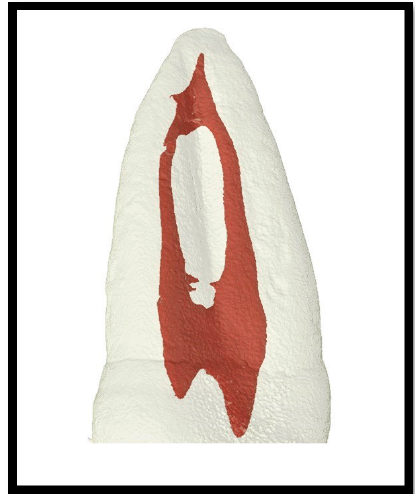
Figure 2. Micro-CT image showing Vertucci’s type II (2-1) canal configuration.